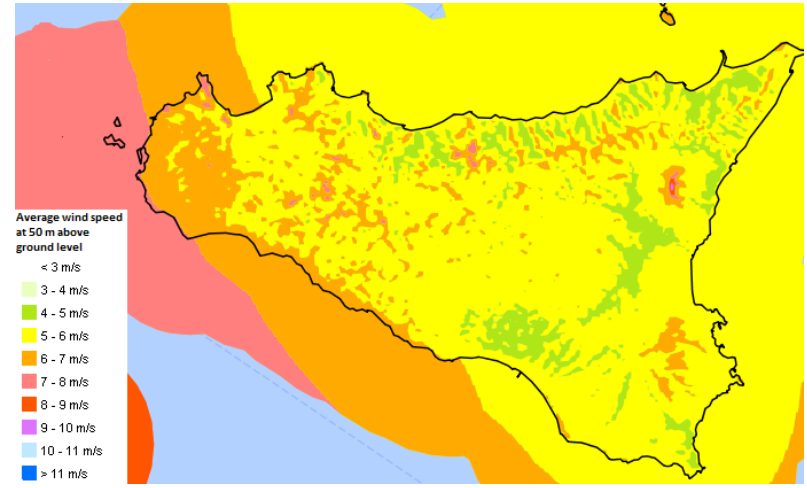
Figure 2. Average wind speed in Sicily at 50 m above ground level [21].